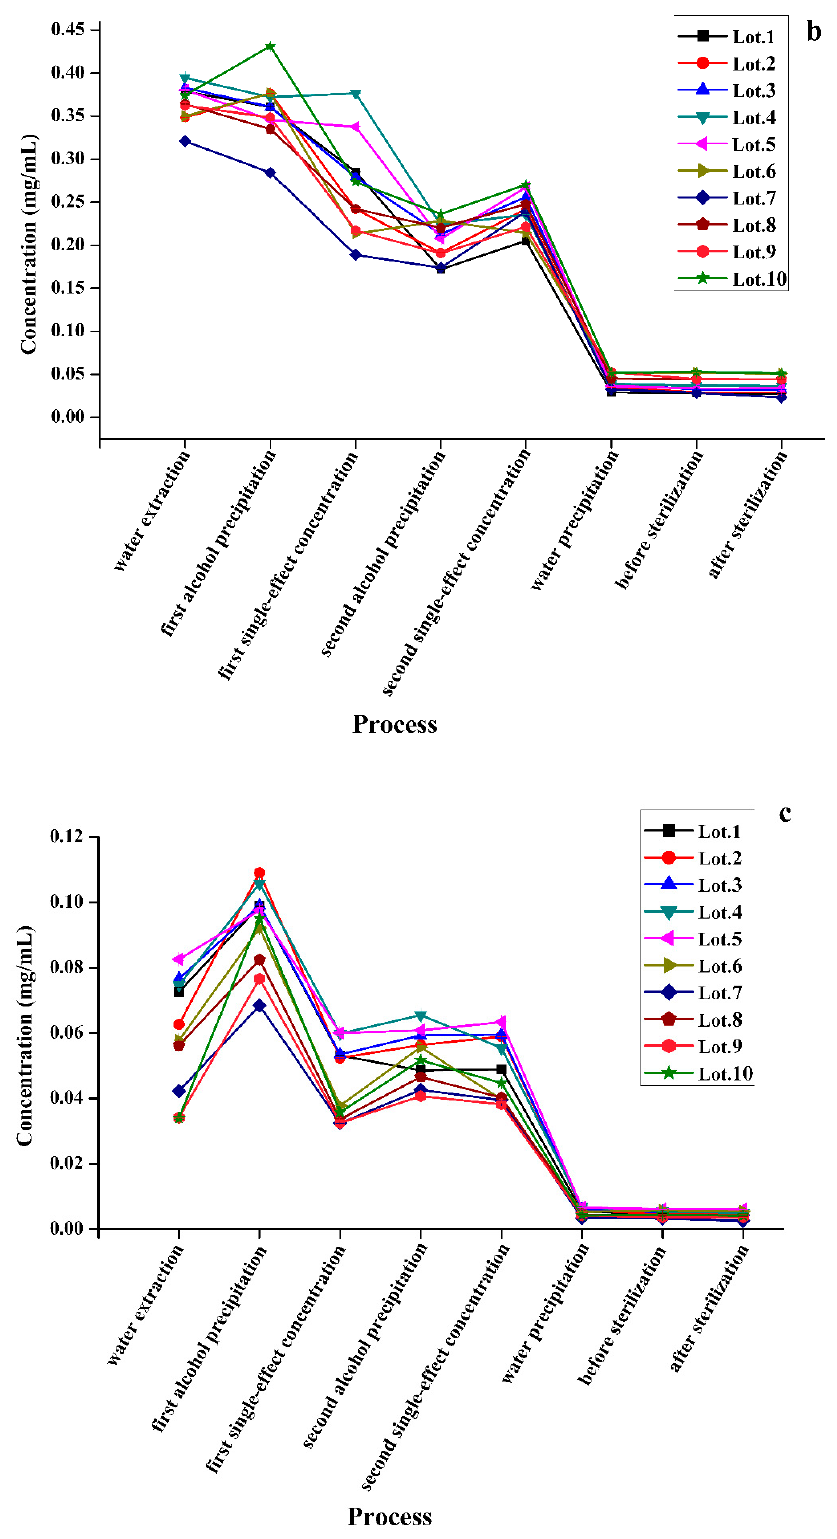
Figure 5. HPLC-PDA chromatograms of ( a ) the sample solution of Schisandra chinensis extract intermediates including the processes of water extraction (three times), first alcohol precipitation, first single-effect concentration, second alcohol precipitation, second single-effect concentration, water precipitation, before sterilization, and after sterilization (1: SolA, 2: SolB). The transfer process of ( b ) SolA, ( c ) SolB.